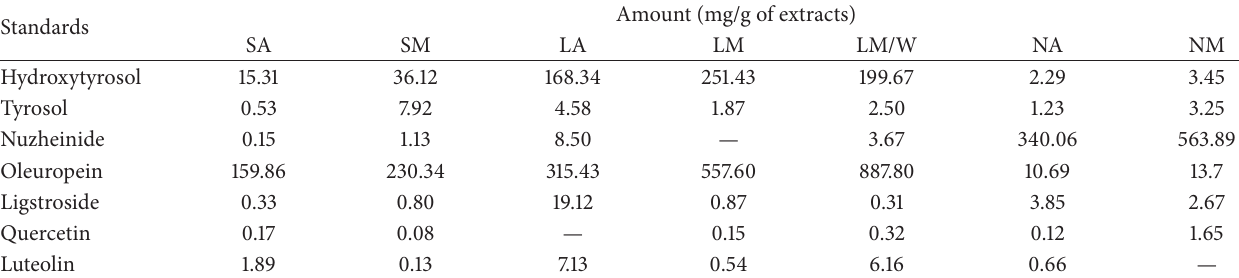
Table 2: Quantification of the principal compounds in chetoui O. europaea variety extracts. Standards